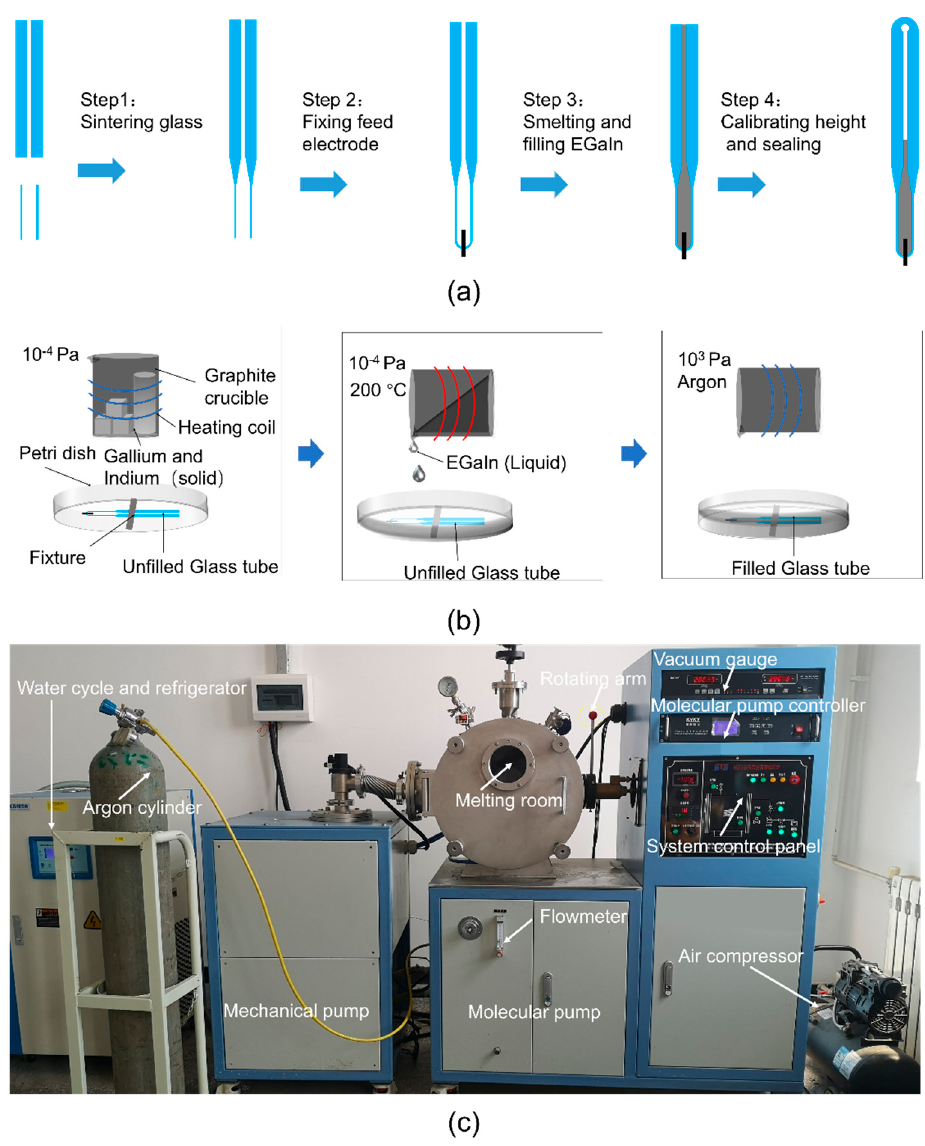
Figure 3. ( a ) The manufacturing process of the antenna radiating element. ( b ) The smelting and filling processes of EGaIn (Step 3). ( c ) The smelting and filling equipment of EGaIn (Step